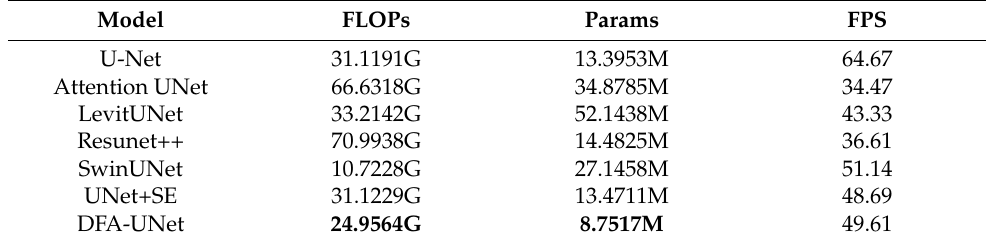
Table 2. Comparison of other parameters of different models.